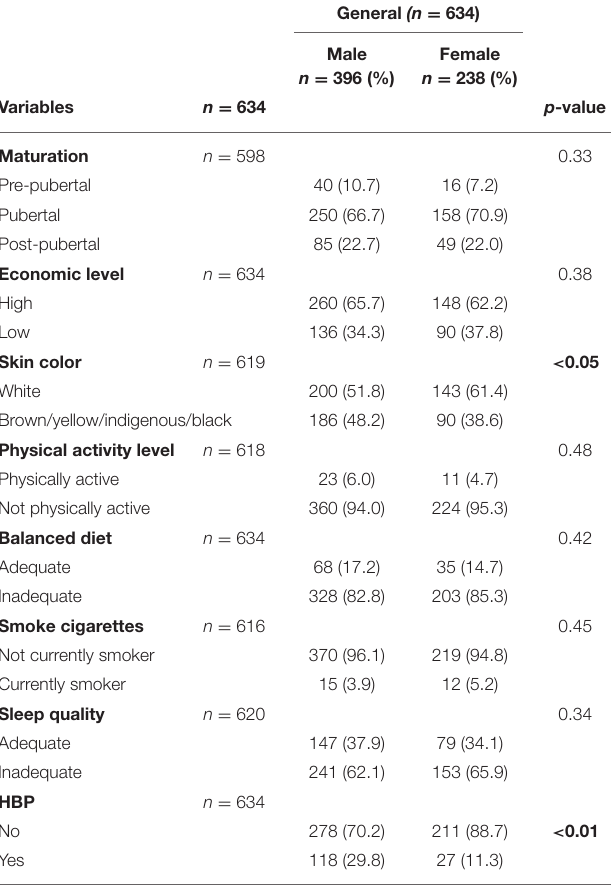
TABLE 2 | Physical, sociodemographic, and lifestyle characteristics of public school students in São José, SC,